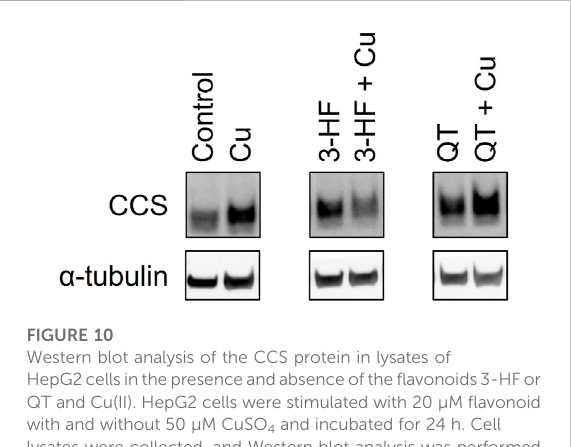
FIGURE 10 Western blot analysis of the CCS protein in lysates of HepG2cellsinthepresenceandabsenceofthe fl avonoids3-HFor QT and Cu(II). HepG2 cells were stimulated with 20 μ M fl avonoid with and without 50 μ M CuSO 4 and incubated for 24 h. Cell lysates were collected, and Western blot analysis was performed using antibodies speci fi c for CCS with α -tubulin as a control. Western blot images for the remaining assessed fl avonoids are shown in Supplementary Figure